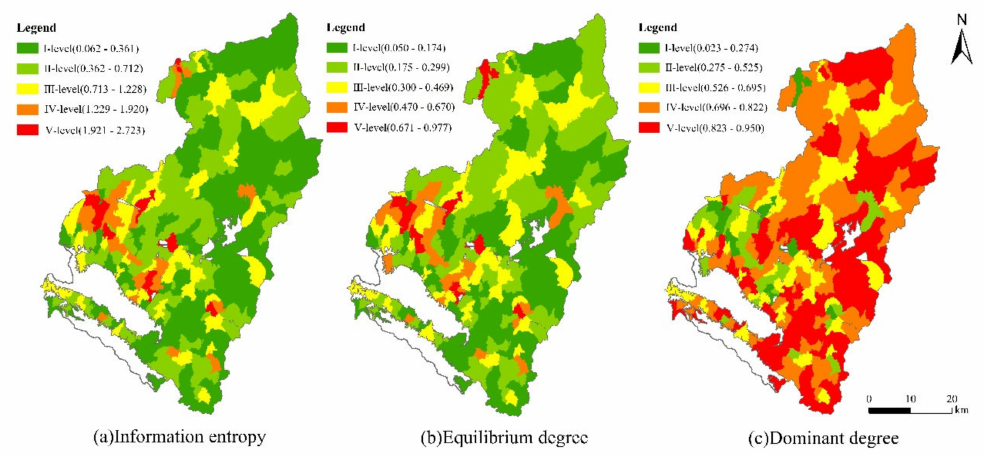
Figure 4. The quantitative structure of the internal land use in the residential area. ( a ) Information entropy, ( b ) Equilbrium degree, ( c ) Dominant